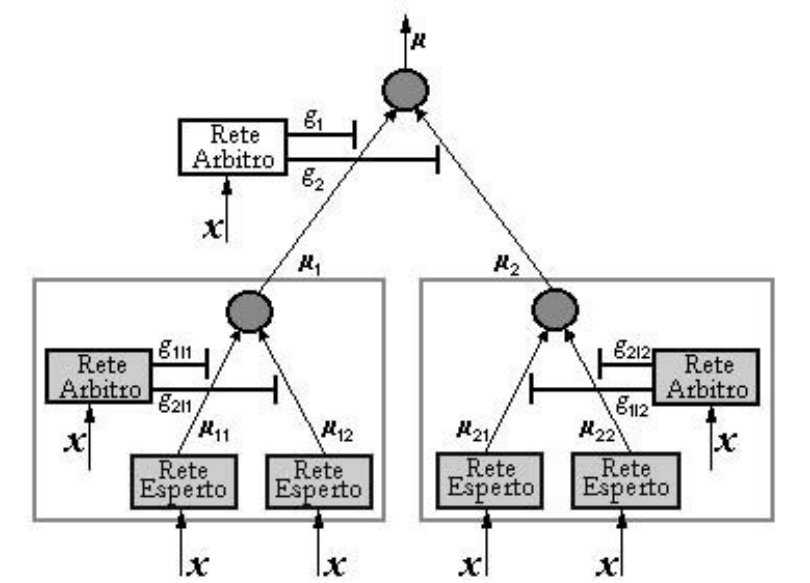
Figura 2 – Rappresentazione grafica di un modello HME a due livelli con fattore di ramificazione ( branching factor ) pari a 2 visto come rete neurale modulare (adattato da Jordan e Jacobs 1994). Notare come sia le reti esperti che le reti arbitro ricevano in entrata il vettore di covariate